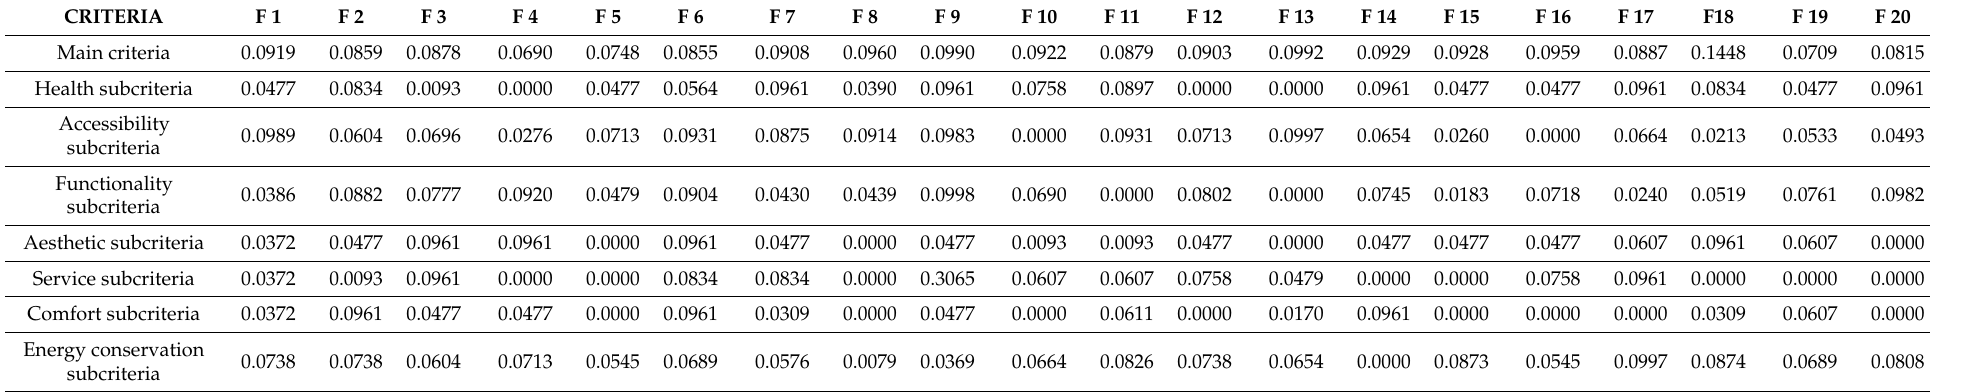
Table 4. AHP consistency ratio results (f = 20).